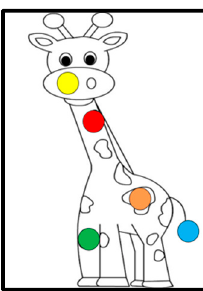
Figure 3. Example of the items used in the Mr. Giraffe test (5 spots—condition).